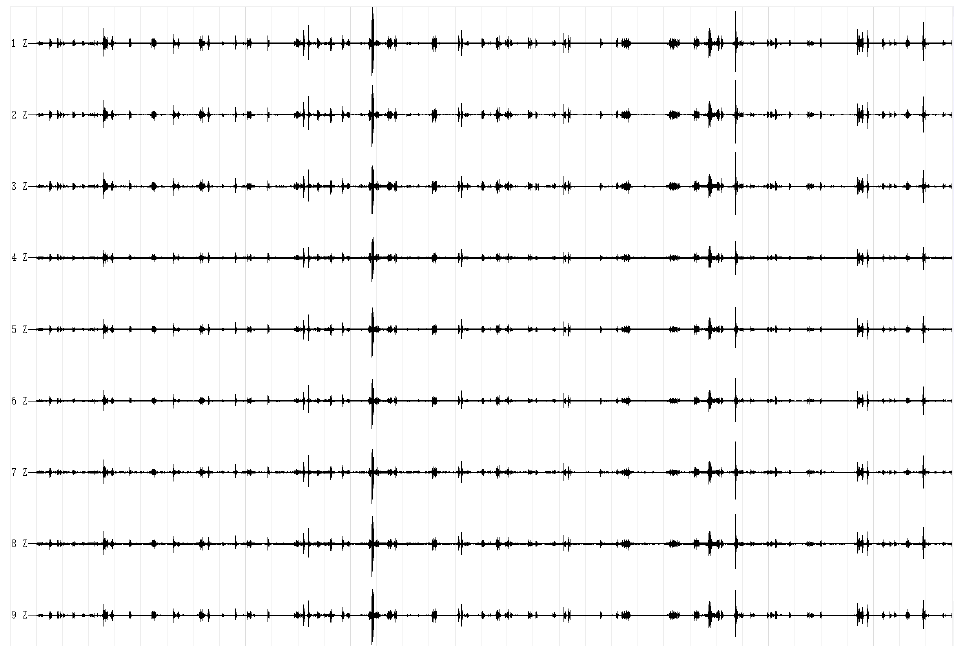
Figure 7. Arrangement of the observation array.